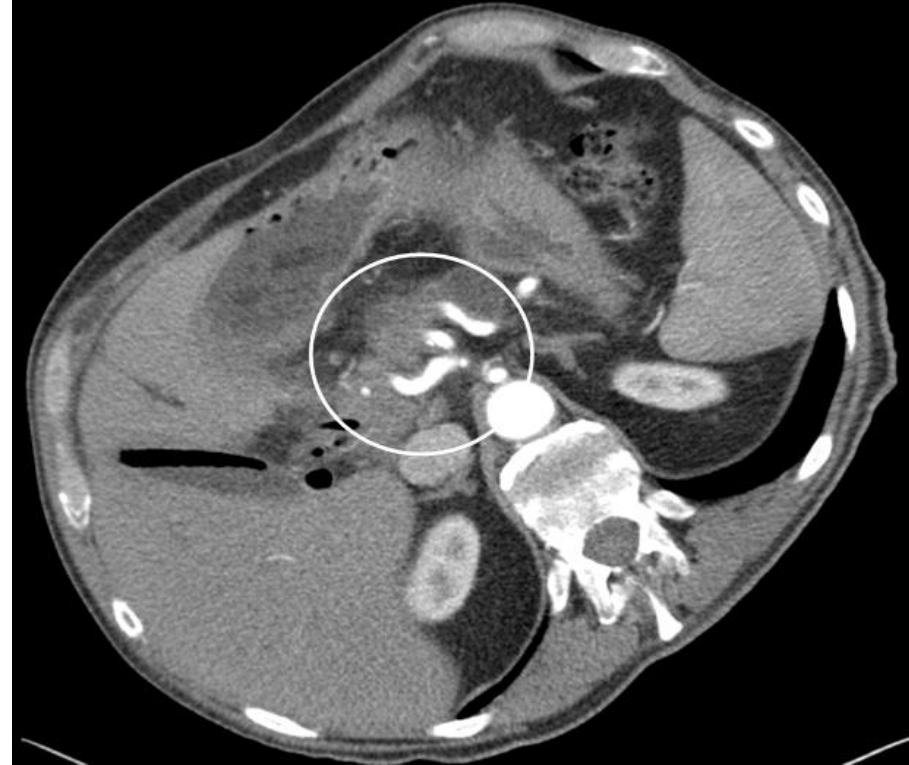
Figure 3. CT scan showing pancreatic head cancer with infiltration of the celiac trunk. Infiltration of common hepatic, left gastric and splenic artery (white circle, left, middle and right vessel). Technically not resectable